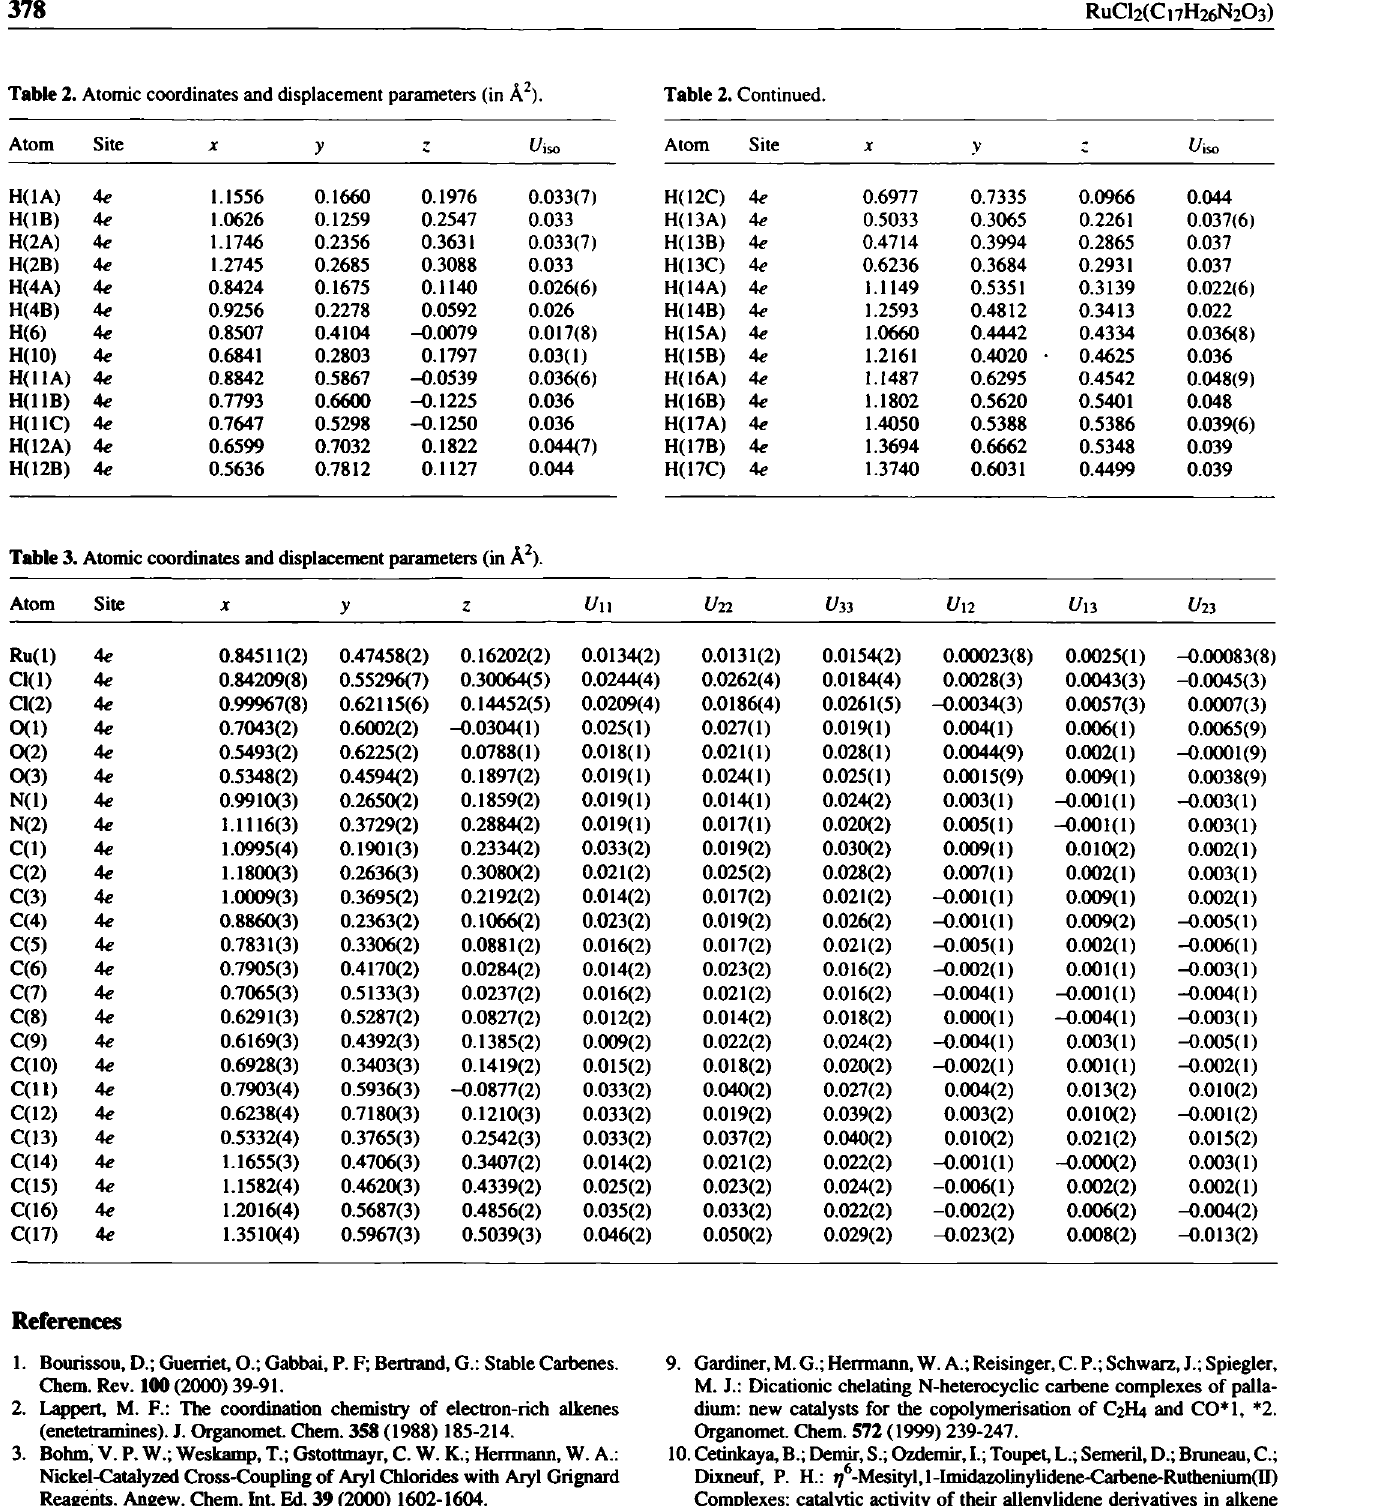
Table 2. Atomic coordinates and displacement parameters (in Â 2 ).